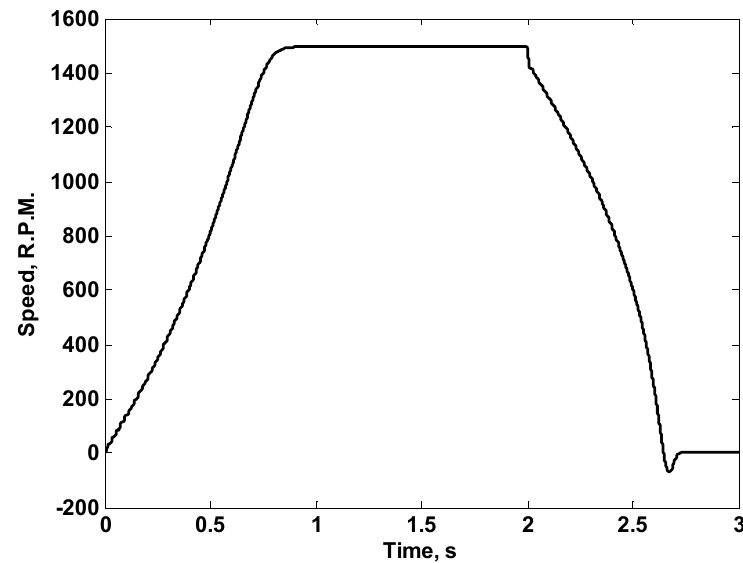
Figure 26. Motor Speed, Braking Occurs at 2 s.